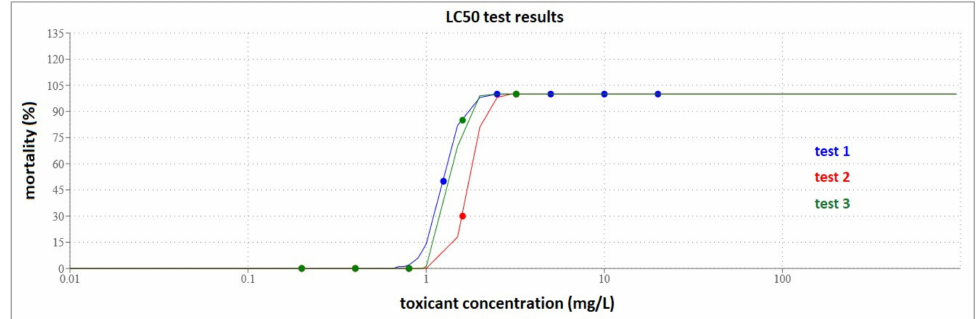
Figure 6. LC 50 calculation for the reference toxicant tests 1, 2, and 3 (LC 50 = 1.250 mg/L, 1.739 mg/L, 1.409 mg/L).